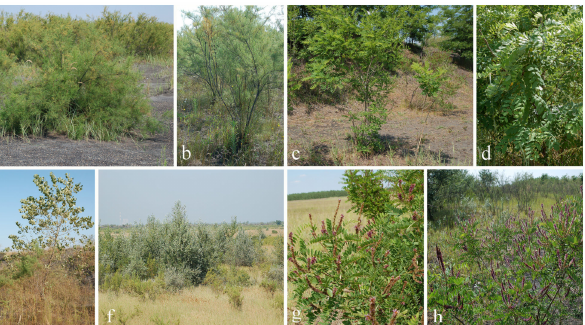
Figure 5. Examined woody plant species: ( a )— T. tetrandra L1, ( b )— T. tetrandra L2, ( c )— R. pseudoacacia L1, ( d )— R. pseudoacacia L2, ( e )— P. alba L1, ( f )— P. alba L2, ( g )— A. fruticose L1 , and ( h )— A. fruticosa